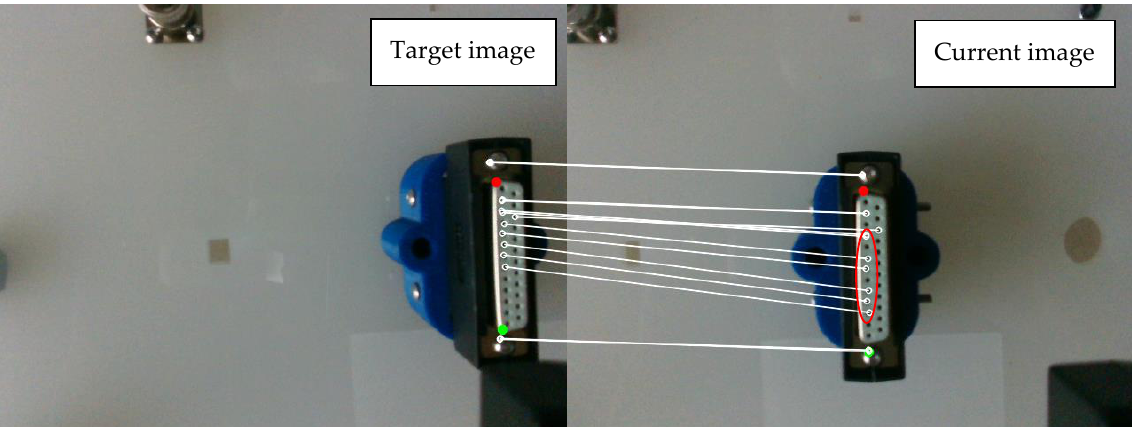
Figure 25. Visual servo based on ORB method (some wrong matches). Further comparison between the ORB and P2HNet methods is shown in Table 4. Table 4. Comparison between the ORB and P2HNet methods.